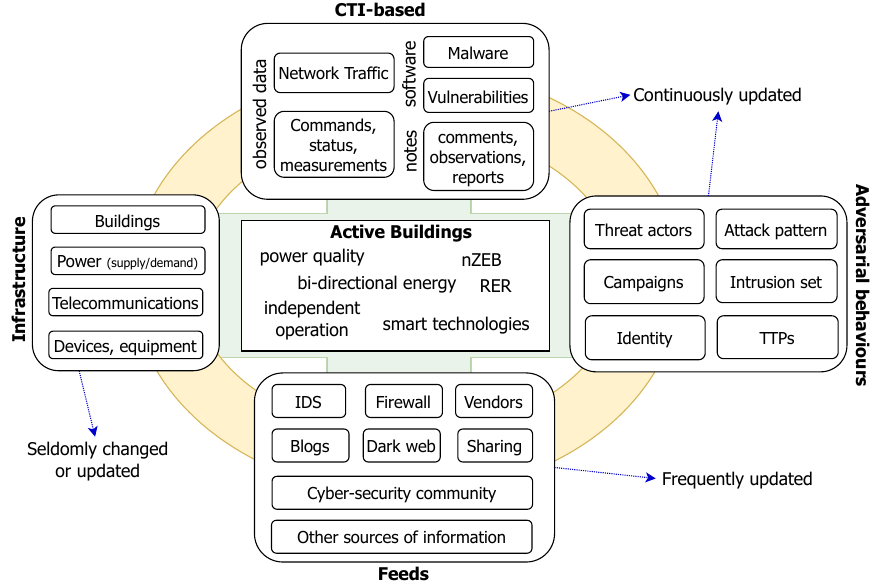
Figure 4. Modelling effort for Active Buildings encompassing infrastructure, intelligence, and feeds, all coupled with adversarial